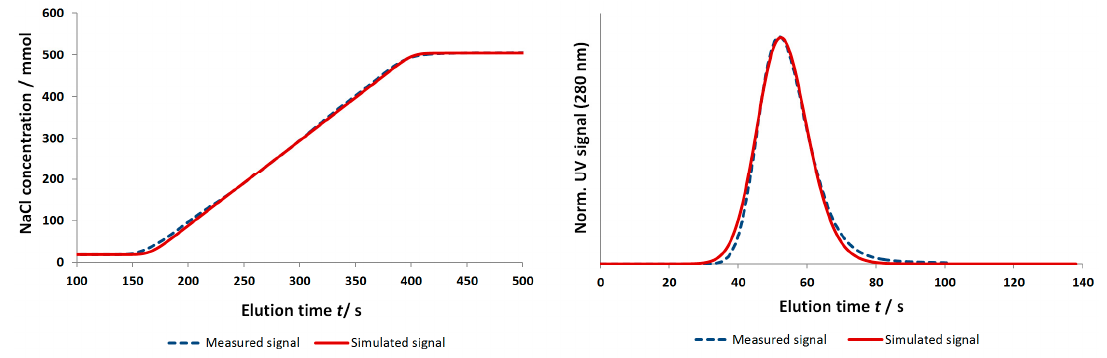
Figure 6. Comparison between measured and simulated tracer signal (right) and salt gradient (left).